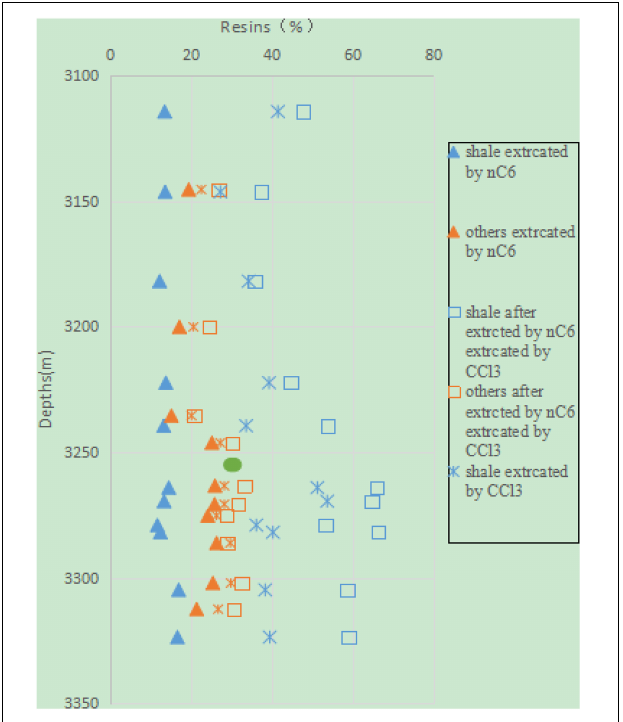
FIGURE 5 | Depth profile of the extract contents of the non-hydrocarbon from the mud shale versus the non-mud shale after different extraction treatments.